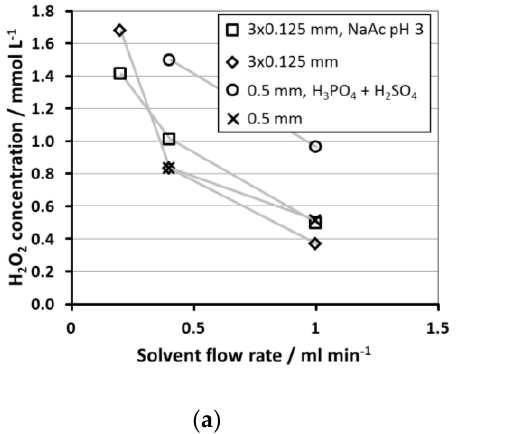
solvent (Table 1 Exp.-Nr.: 67). In comparison with the literature, only Biasi et al. found similarly low productivities of 180 mol H2O2 /kg Pd /h using methanol without additives as solvent in a trickle bed reactor. In continuous flow experiments, most of the groups found productivities between 1500 and 6000 mol H2O2 /kg Pd /h [41,43,44,48,52,54,55,62]; only Kanungo et al. [46] stood out with achieving